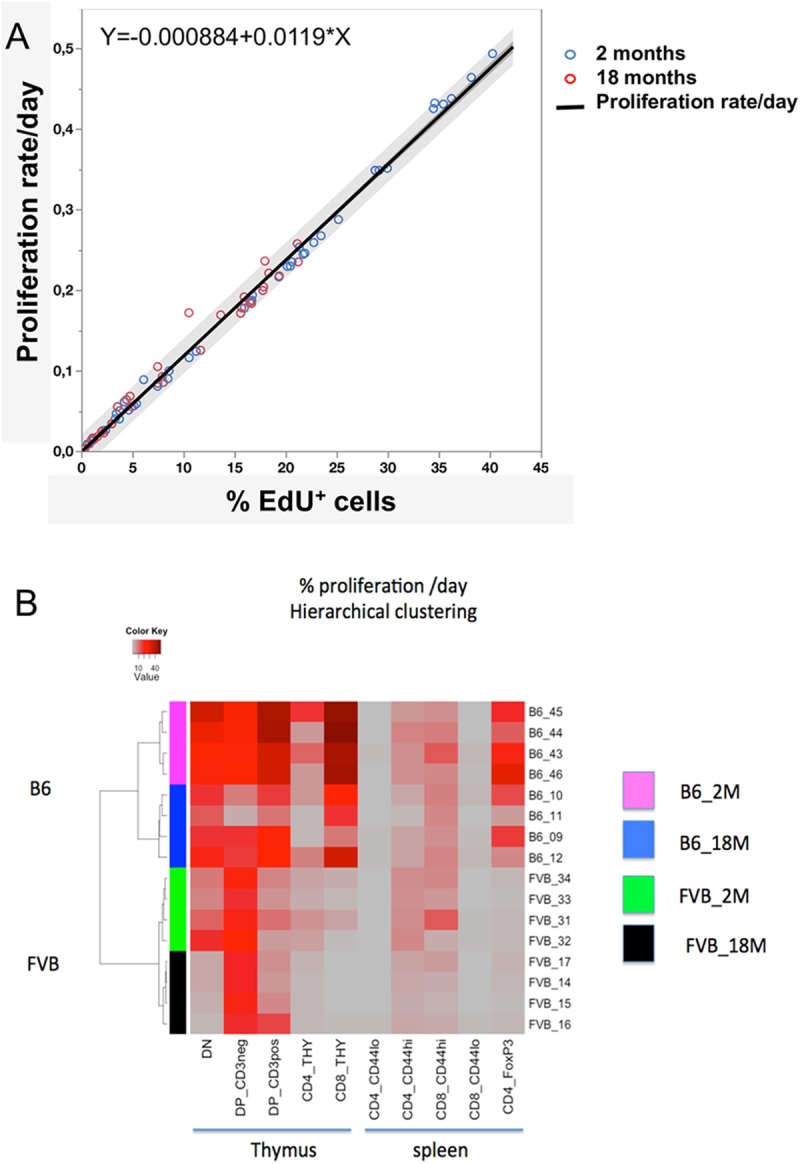
Signatures of lymphocyte proliferation according to strains and ages.The upper panel shows the correlation between the percentages of EdU+ cells observed 16 h after the pulse/chase/pulse experiment in thymus of B6 and FVB mice (80 values) and according to the age of mice (2 months: blue circle, 18 months: red circles). Hierarchical unsupervised clustering showing the clusters of mice according to the rates of proliferation. Values and statistics are given in S1, S2, S3 and S4 Tables. Proliferation rates/day are significantly different (p<0.05) comparing: In thymus: B6 2M vs B6 18M: 2M>18M in DP, CD8; FVB 2M vs FVB 18M: 2M>18M in DN and CD4; B6 2M vs FVB 2M:B6>FVB in DP CD3+, CD8; B6 18M vs FVB 18M:B6>FVB in CD8. In spleen: B6 2M vs B6 18M: 2M>18M in CD4 CD44hi; FVB 2M vs FVB 18M: 2M>18M in CD4 CD44hi;B6 2M vs FVB 2M:B6>FVB in CD4, CD4 Foxp3+; B6 18M vs FVB 18M:B6>FVB in CD4 Foxp3+, CD8 CD44hi